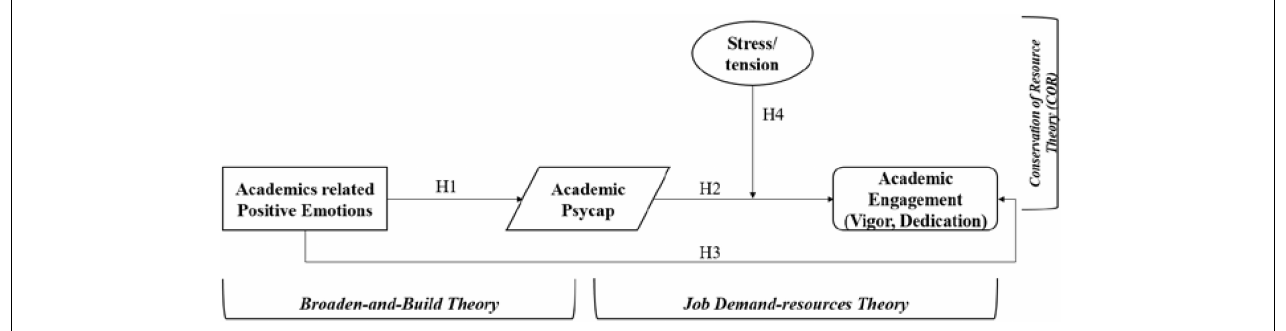
FIGURE 1 | Proposed research framework.